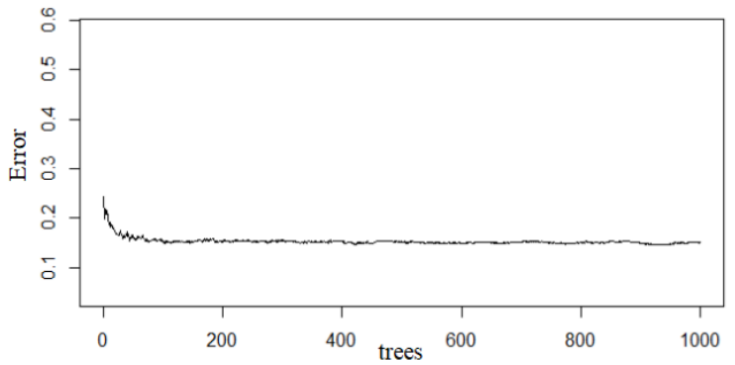
Figure 6. The relationship between the number of decision trees and the error rate.